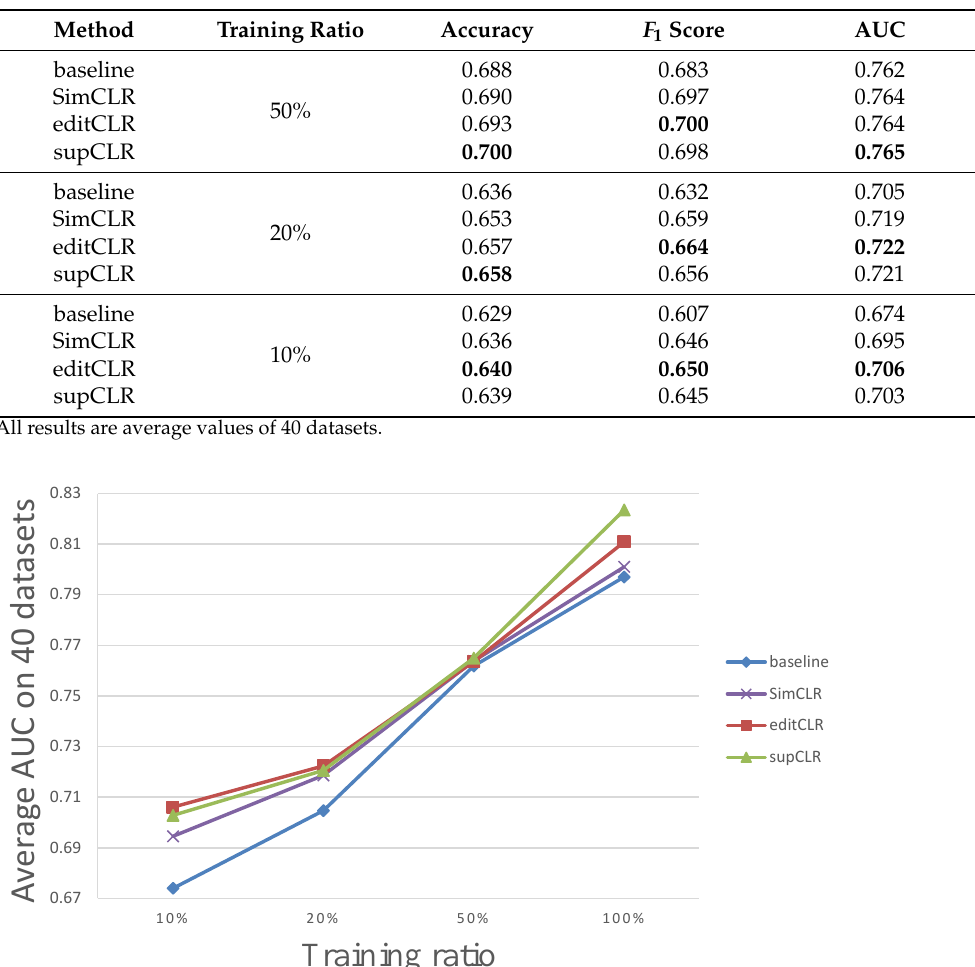
Table 3. Performance results on DEEPre dataset.